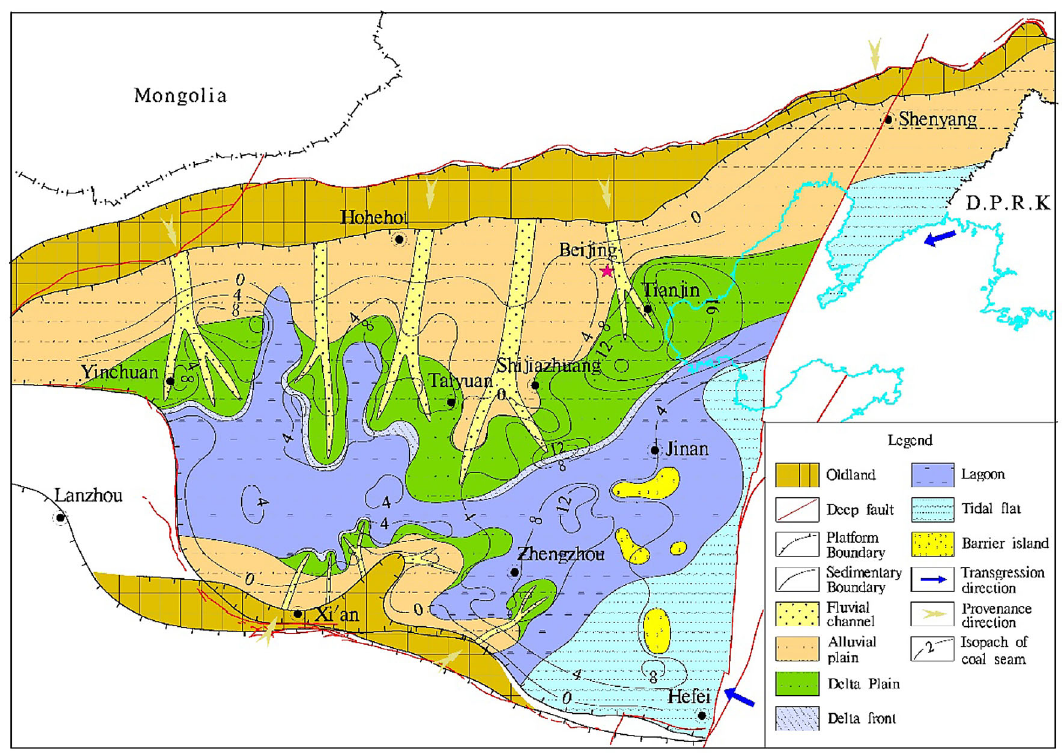
Fig. 6 Sequence-paleogeography and coal-accmmulating regularities of SQ3 (Shanxi Formation) in the North China CAA